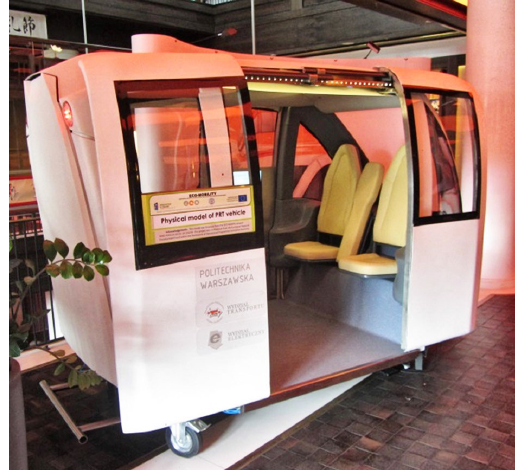
Fig. 3. PRT cabin